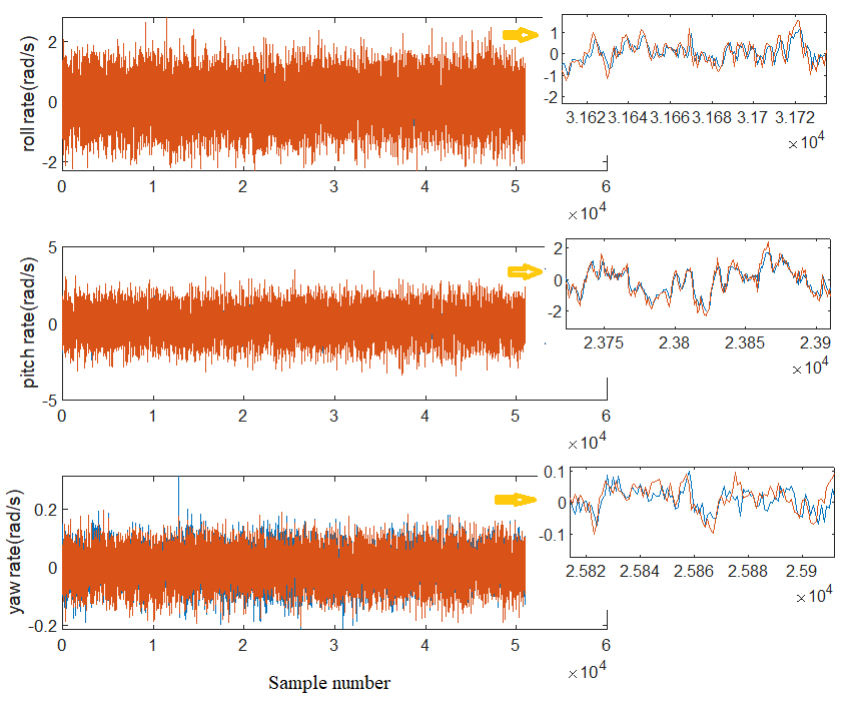
Figure 10. Estimated same angular rates of the LSTM training set: red line represents LSTM output; blue line represents sample output.